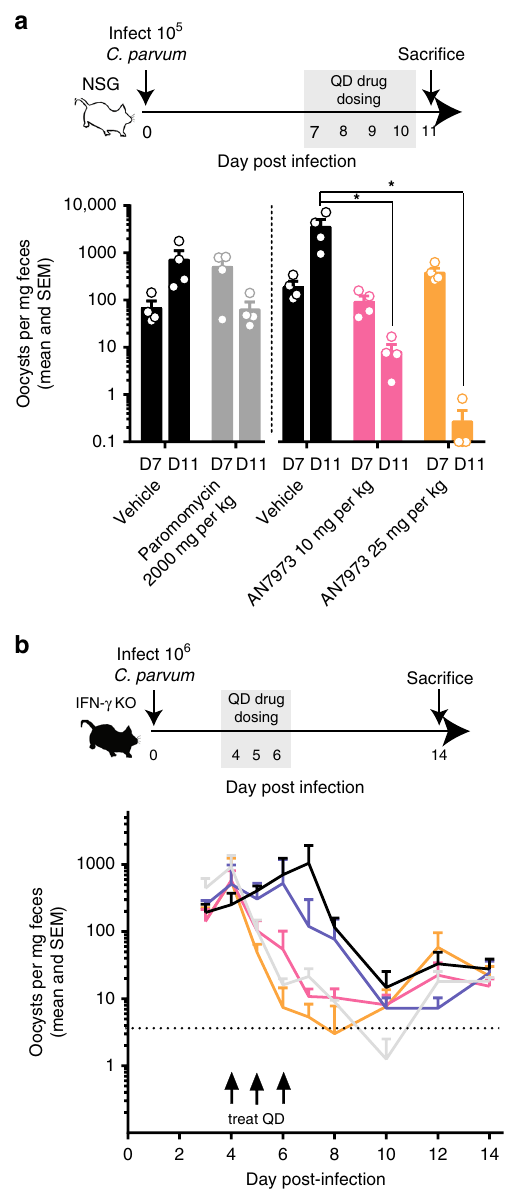
Fig. 4 AN7973 ef fi cacy in established and acute murine C. parvum infections. a Effect of AN7973 on established cryptosporidiosis in NOD scid gamma mice. C. parvum (Bunch Grass Farms Iowa isolate) infection was established by oral gavage of ∼ 10 5 oocysts and allowed to progress for 7 days prior to once daily oral administration of paromomycin